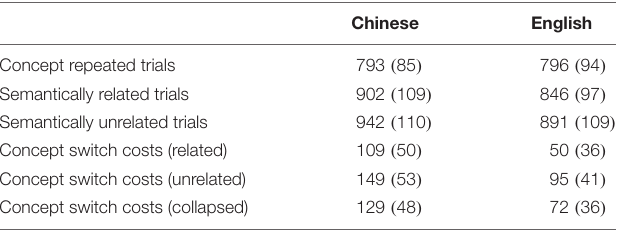
TABLE 5 | Mean RTs in ms (SD) in single- and mixed-language blocks and mixing costs presented separately for Chinese and